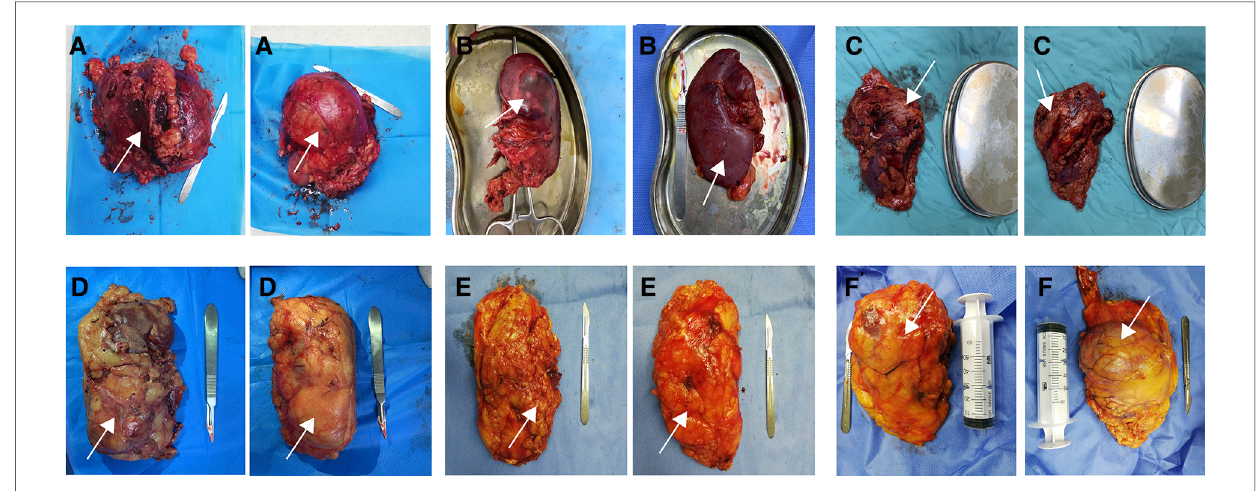
FIGURE 1 Diagram of the scoring criteria. A-1 point; B-2 point; C-3 points; D-4 points; E-5 points; F-6 points. Arrows in the fi gure indicate the location of the